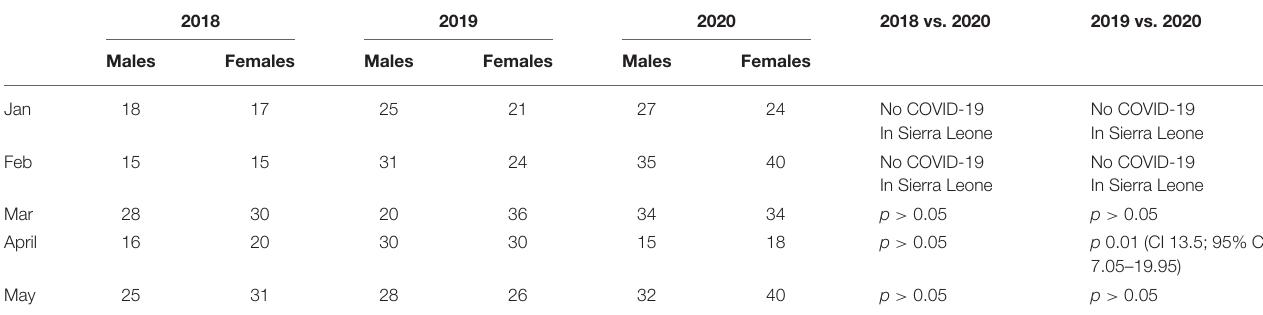
TABLE 1 | Malaria diagnoses in children younger than 5 years of